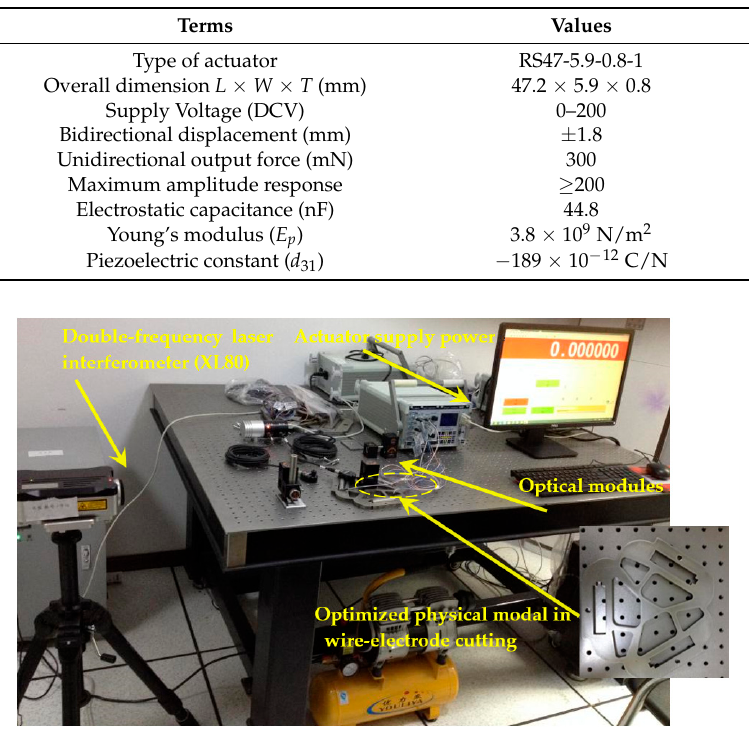
Figure 21. The control and measurement worktable for PZT-based micro/nano displacement.